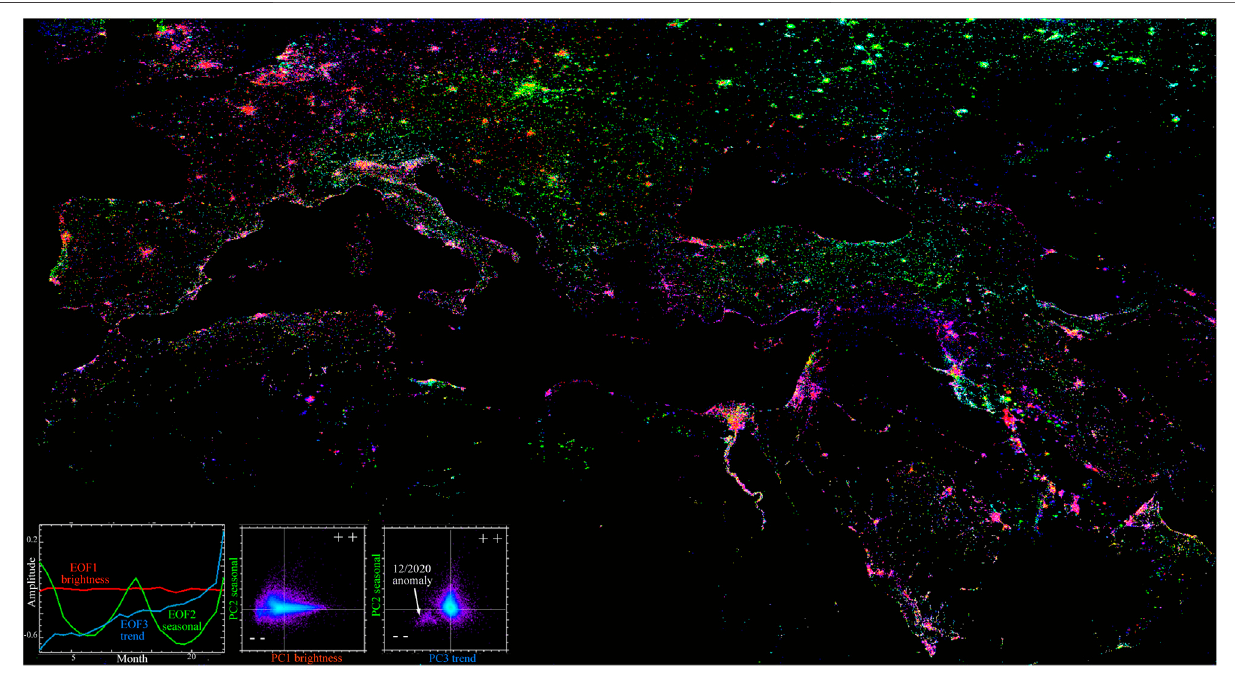
Frontiers in Remote Sensing |